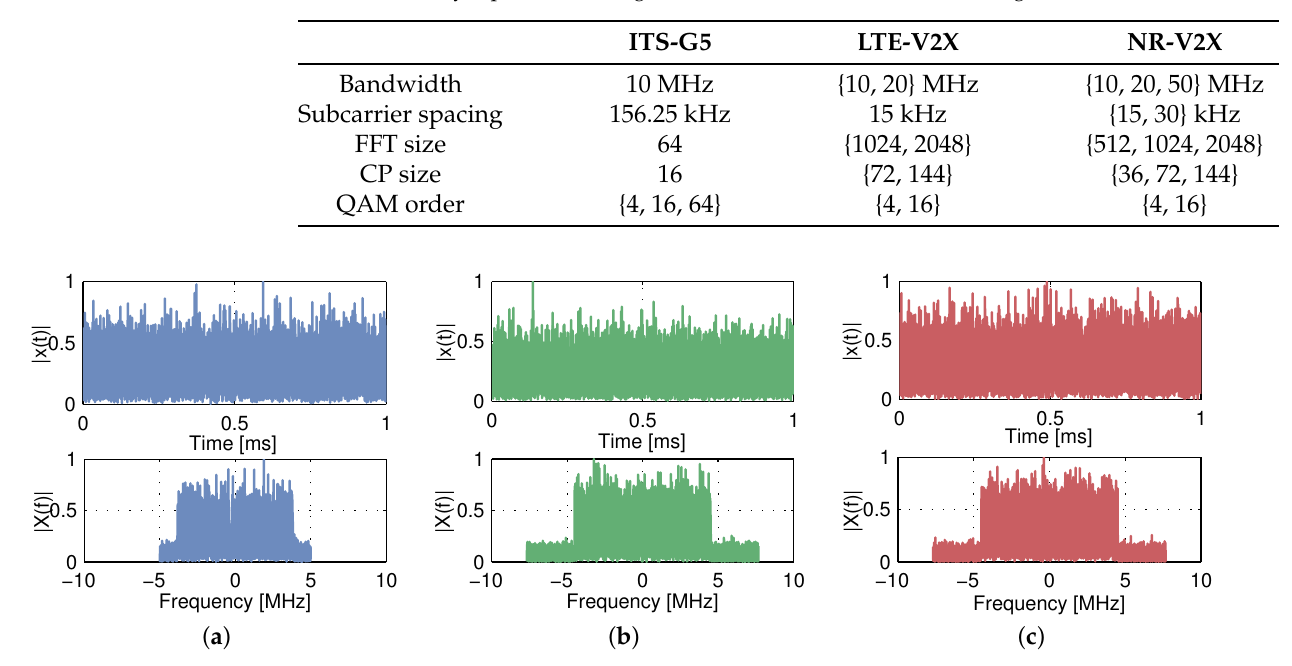
Figure 2. Time and frequency domain representation of received ( a ) ITS-G5 ( b ) LTE-V2X and ( c ) NR-V2X signals at SNR = 10